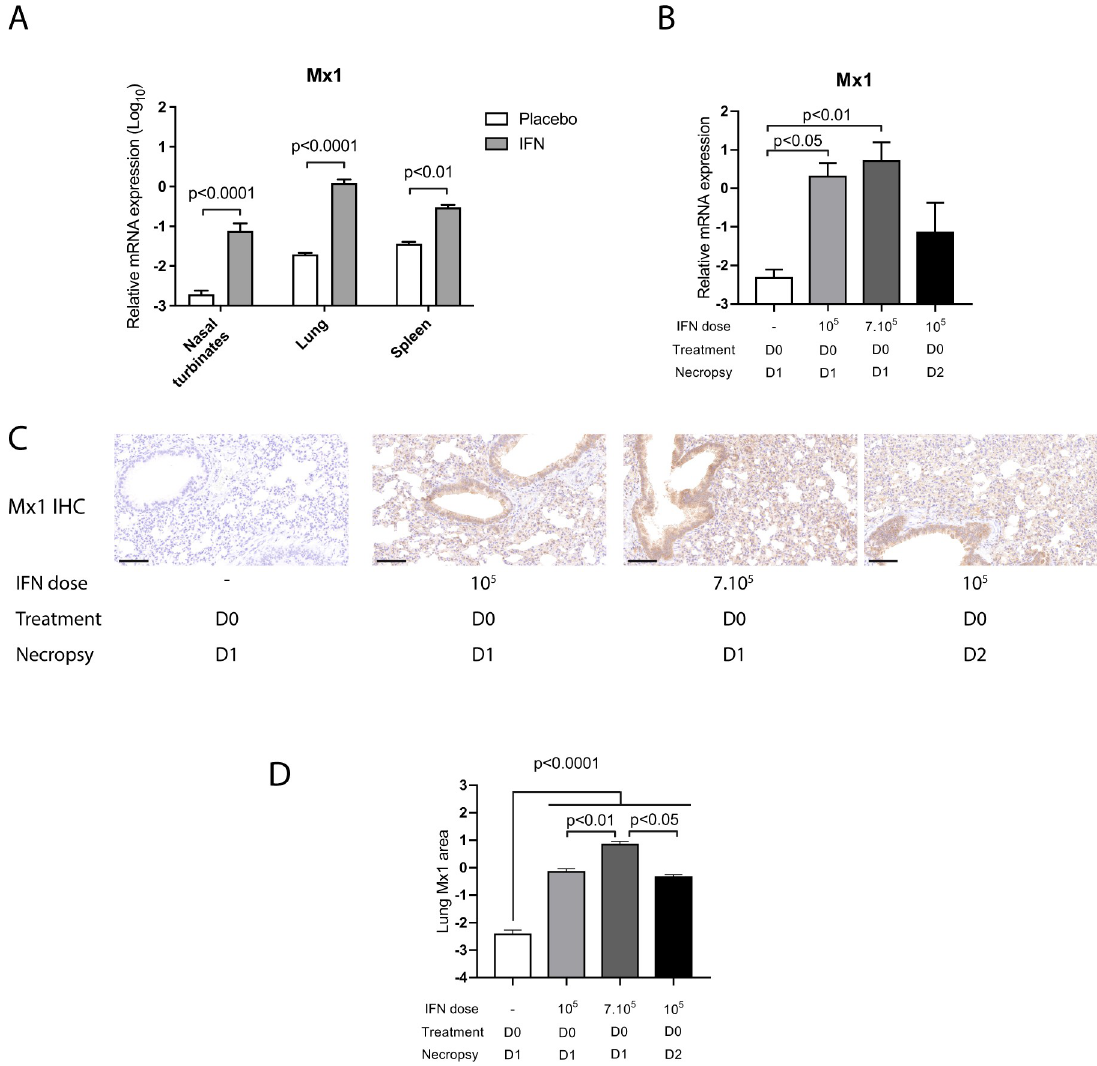
Fig 1. Impact of IFN- α treatment on Mx1 lung transcript and protein levels in non-infected hamsters. (A) Syrian hamsters were treated intranasally either with placebo or with 10 5 IU recombinant universal IFN- α (IFN). Tissues were harvested at day 1 post- treatment. Transcripts levels of Mx1 relative to the housekeeping genes RPL18 and RPS6KB1 were determined by RT-qPCR. Results are expressed as means ± SEM. Statistical analysis: one-way ANOVA with Tukey’s multiple comparisons test. (B-D) Syrian hamsters were treated intranasally either with placebo or with 10 5 UI IFN or with 7.10 5 IU IFN. Tissues were harvested either at day 1 or day 2 post- treatment. (B) Lung transcripts levels of Mx1 relative to the housekeeping genes RPL18 and RPS6KB1 determined by RT-qPCR. (C) Representative pictures were selected to display Mx1 lung protein levels detected by immuno-chemistry (IHC). Scale bar: 100 μ m. (D) Quantification of percent lung area positive for Mx1 protein detected by IHC. D0: day 0; D1: day 1; D2; day 2. Statistical analysis: one-way ANOVA with Tukey’s multiple comparisons